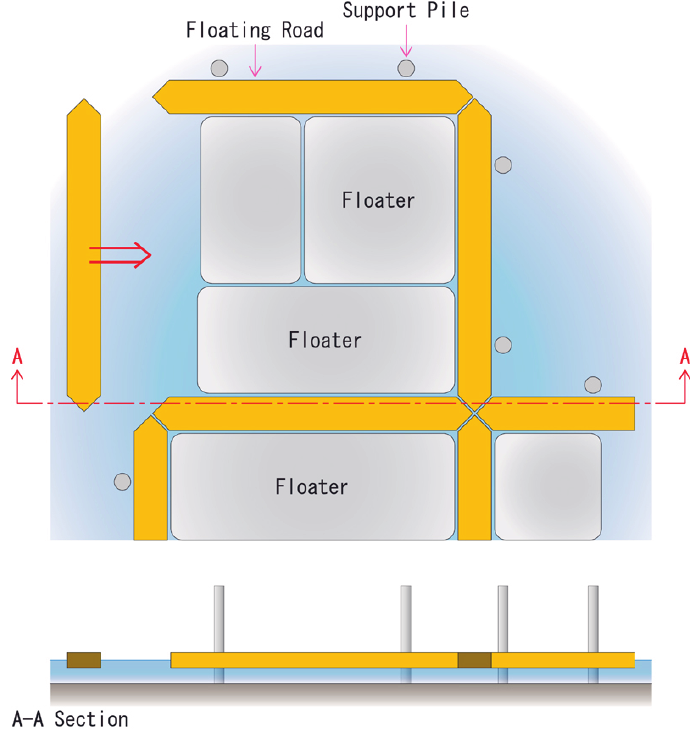
Figure 10. Schematic plan view of the floating roads with